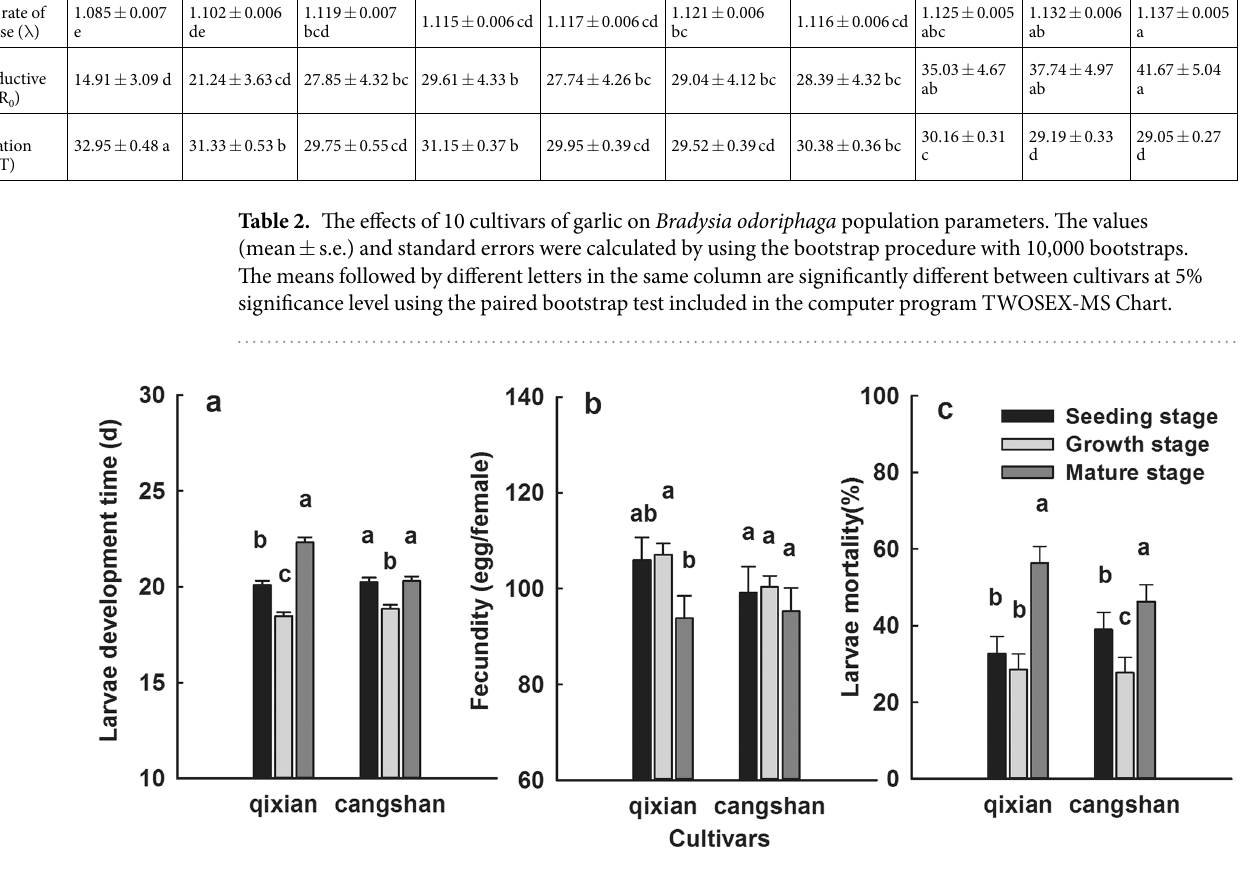
Figure 3. The larva development time ( a ), fecundity ( b ) and larva mortality ( c ) of B. ordoriphyga reared on two cultivars garlic in different growth stages. The values (mean ± s.e.) and standard errors were calculated by using the bootstrap procedure with 10,000 bootstraps. The columns covered by different letters are significantly different between growth stages of garlic at 5% significance level using the paired bootstrap test included in the computer program TWOSEX-MS